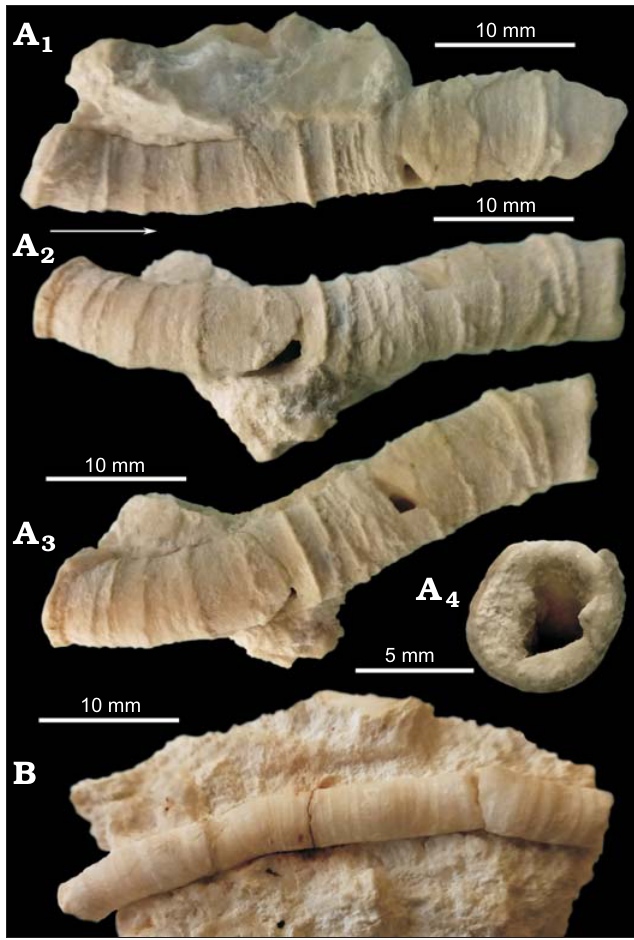
Fig. 2. New serpulid polychaetes from the Wordian to upper Permian, “Pietra di Salomone” Limestone, Sicily, Italy. A . “ Serpula ” calannai sp. nov. (holo- type MSNC 4549-33); general views (A 1 –A 3 ), cross section of tube, white limestone partly filling lumen (A 4 ). B . “ Serpula ” prisca sp. nov. (holotype PMC.S5.15.09.2017); general view of anterior end, partially embedded in rock. Arrow indicates growth directions for all